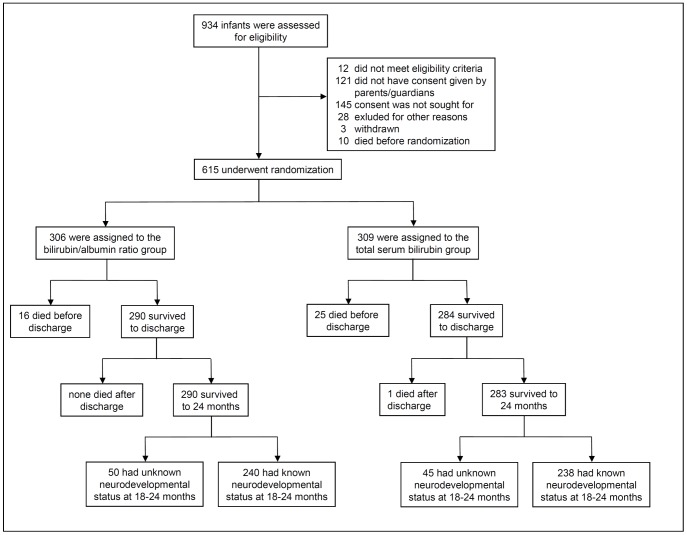
Enrollment, randomization, and follow-up.At follow up there were no significant baseline differences between infants with known and those with unknown neurodevelopmental status.